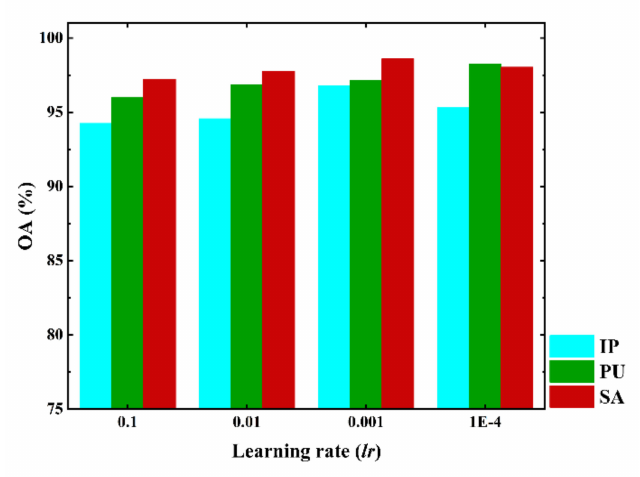
Figure 10. Comparison of OA using different lr values for the three datasets.